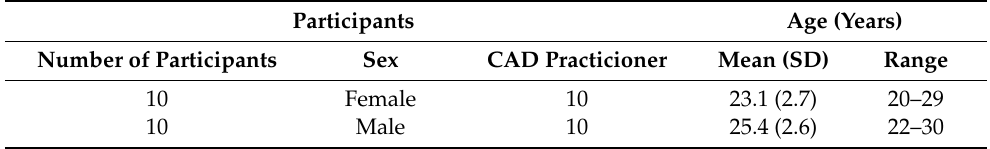
Table 3. Characterization of the sample of